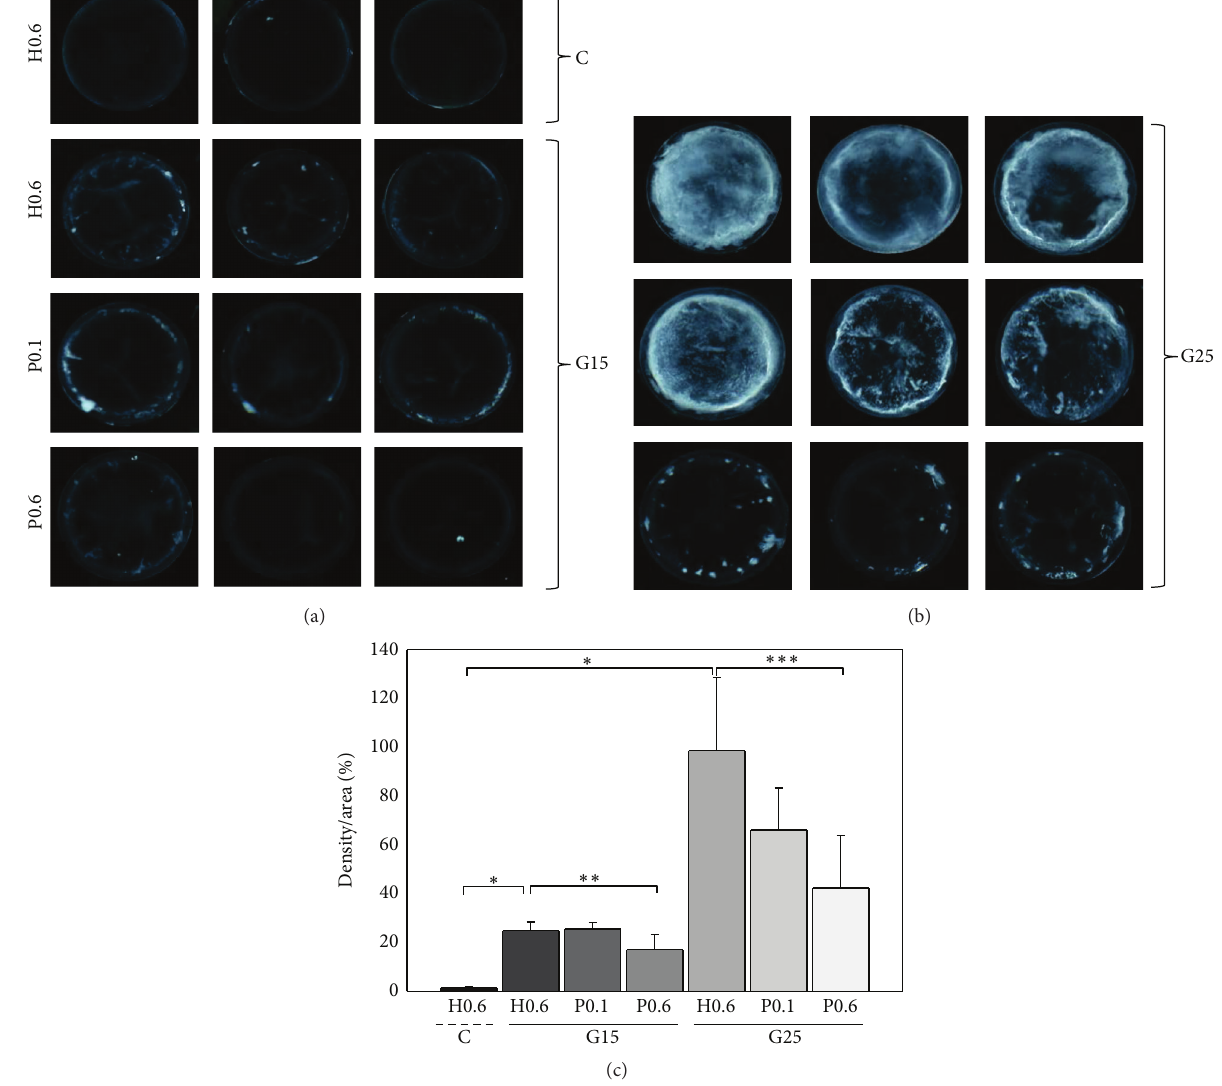
Figure2:Effectofwatersolublepropolisonlensopacityinratsfedahighgalactosediet.Ratsineachgroupweregivenadlibitumaccessto15% or 25% D-galactose mixed with regular chow, as well as being continued on 0.6 g/kg/day purified honey, 0.1g/kg/day propolis, or 0.6 g/kg/day propolis, for 3 weeks. Control rats were allowed ad libitum access to regular chow, as well as being continued on 0.6 g/kg/day purified honey, for 3 weeks. Propolis suppressed lens opacity in rats fed (a) 15% and (b) 25% galactose. (c) Densitometry shows that oral intake of propolis (0.6 g/kg) significantly suppressed lens opacity in galactose-fed rats. Results shown are the mean ± SD of three experiments. Asterisks denote statistically significant differences. ∗ 𝑃 < 0.000006 ; ∗∗ 𝑃 < 0.05 ; ∗∗∗ 𝑃 < 0.01